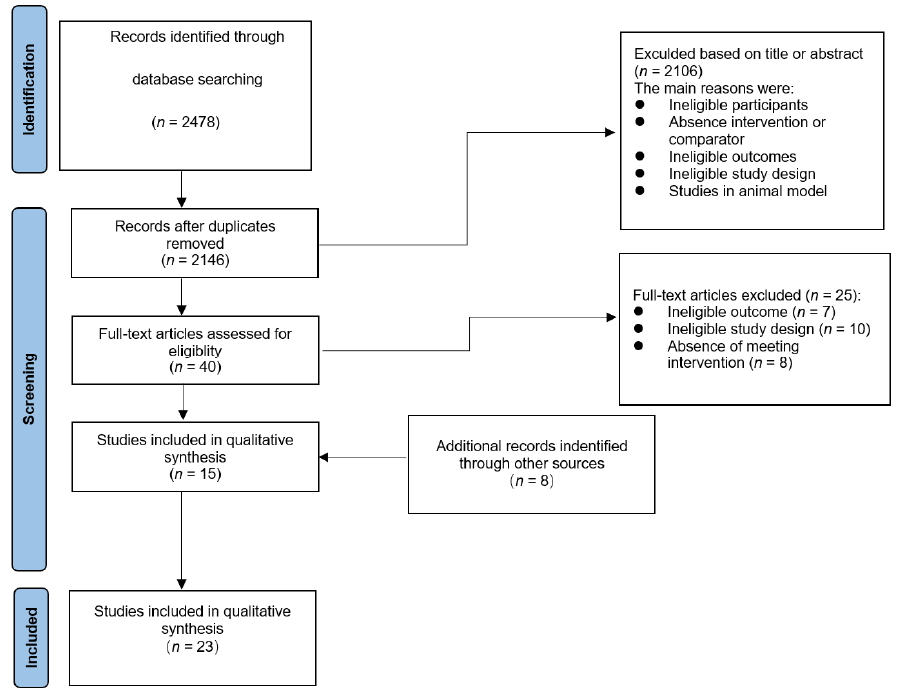
Figure 1. Flow chart of study selection for the analysis of the effects of different hamstring eccentric exercise programs on preventing lower extremity injuries and possible adverse events related to these programs.